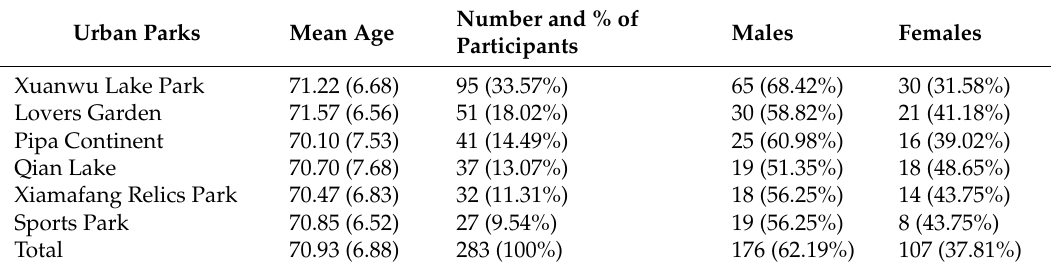
Table 1. Mean age, number, and gender of participants in the six urban parks.